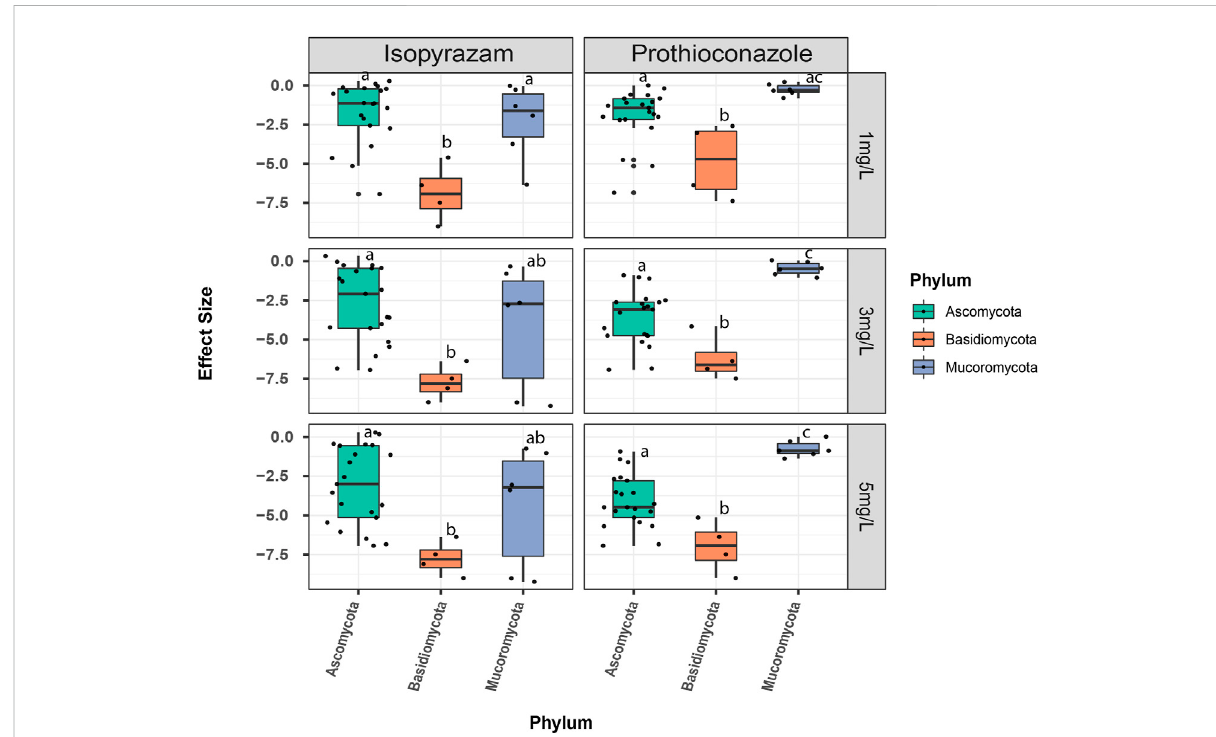
FIGURE 2 Comparison of effect sizes of the fungicide concentrations at the phylum level. Effect sizes (ES) are calculated as the natural logarithm of the responseratiosofthetreatmentandcontrolmeanvalues(LRR=ln( (cid:1) X t / (cid:1) X c ).DotsrepresentESforindividualisolate.Differentlettersdenotesigni fi cant difference between groups ( p <